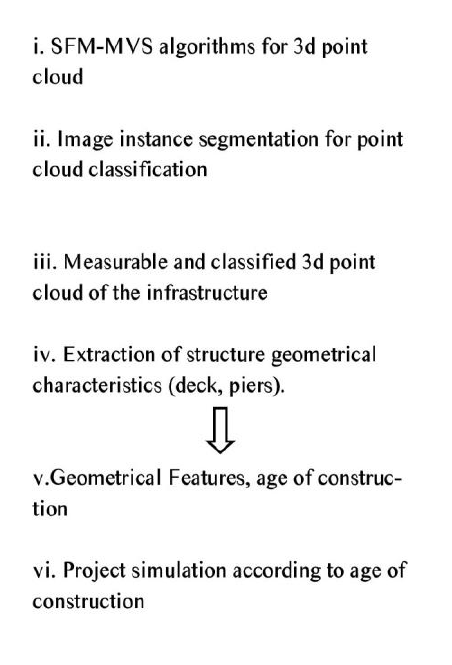
Figure 12. Workflow for structural